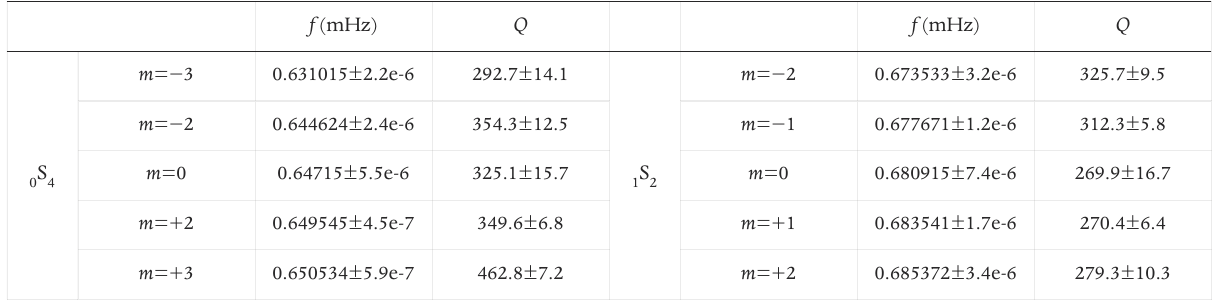
Table 6. The observed weighted average values of frequencies and Q s of